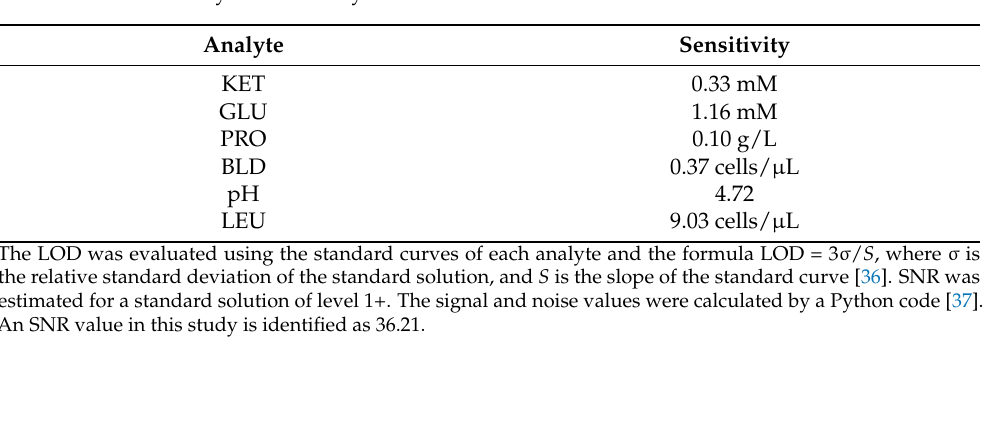
Figure 7. Comparison of the results of the proposed colorimetric urinalysis and those obtained with a hospital instrument for the detection of ( a ) glucose and ( b ) ketone bodies. Table 1. The sensitivity of each analyte.